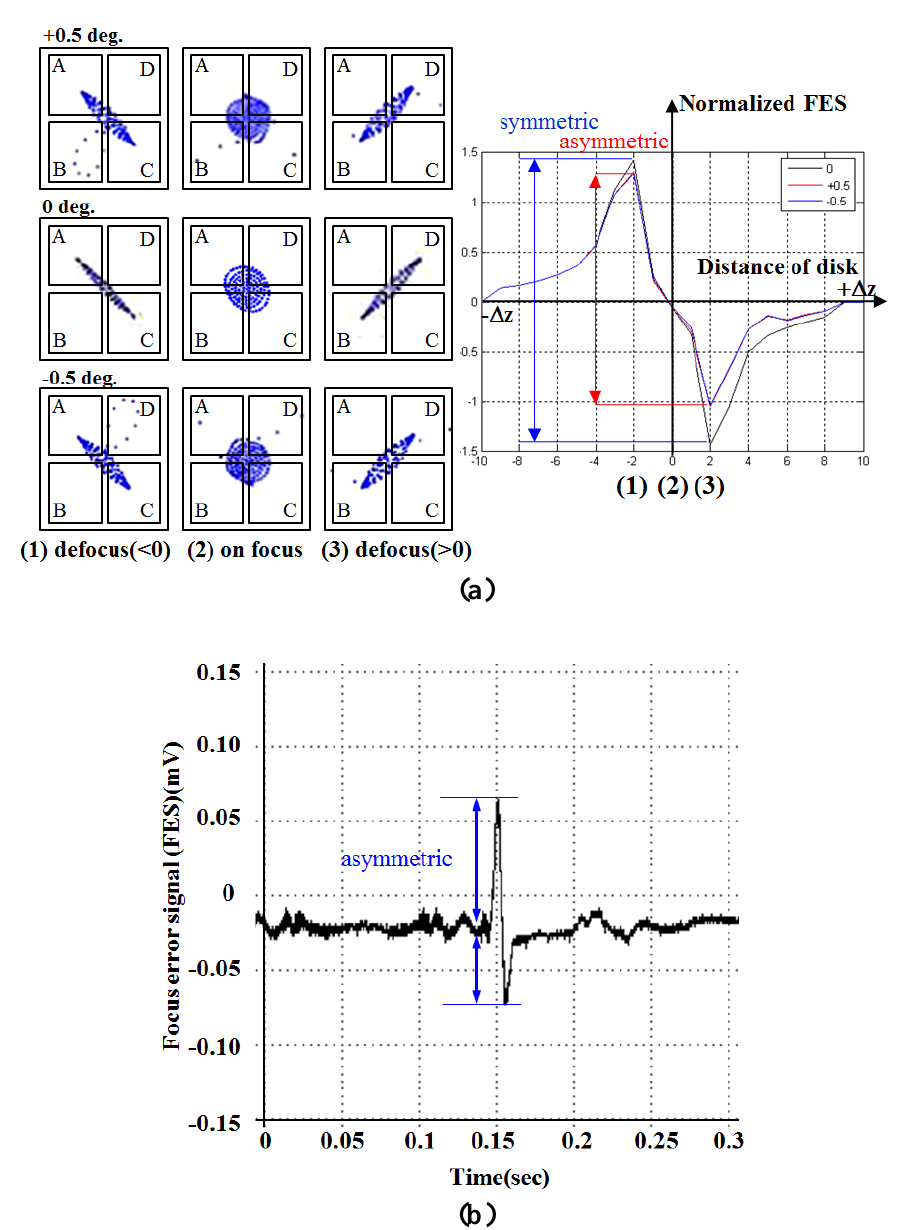
Figure 18. Intensity profiles of the reflected beam on the photo-diode and the output astigmatism signals (S-curve), (a) simulation; (b)